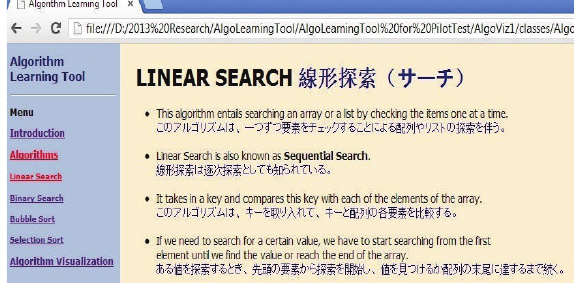
Figure 2: Screenshot of the lecture notes on Linear Search.